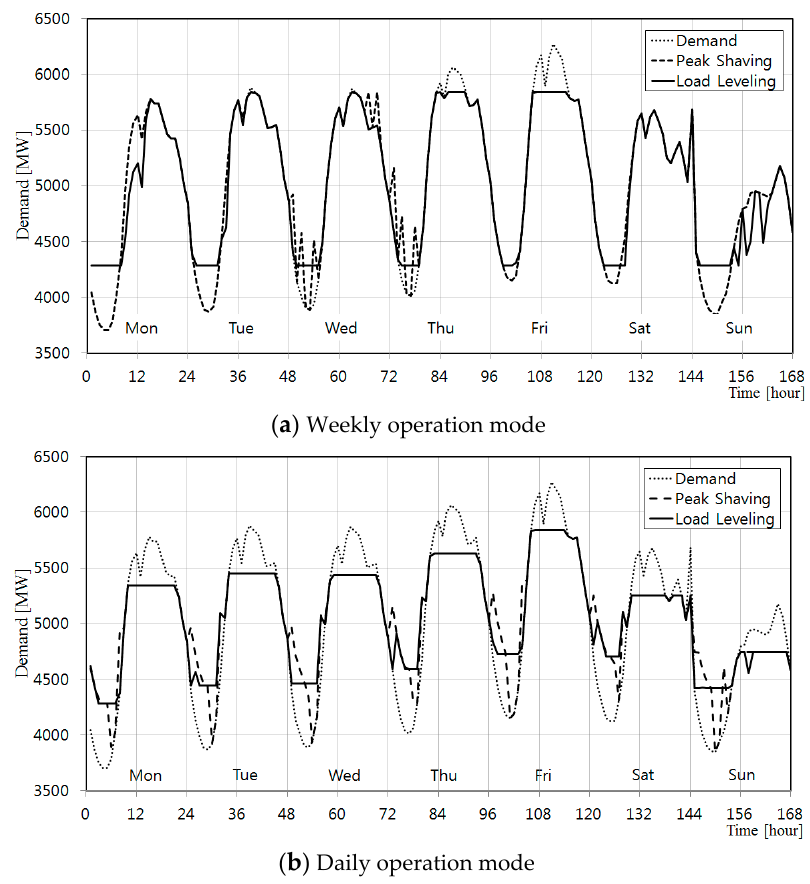
Figure 4. Adjusted demands for a week by peak-shaving and load-leveling models of the ESS.